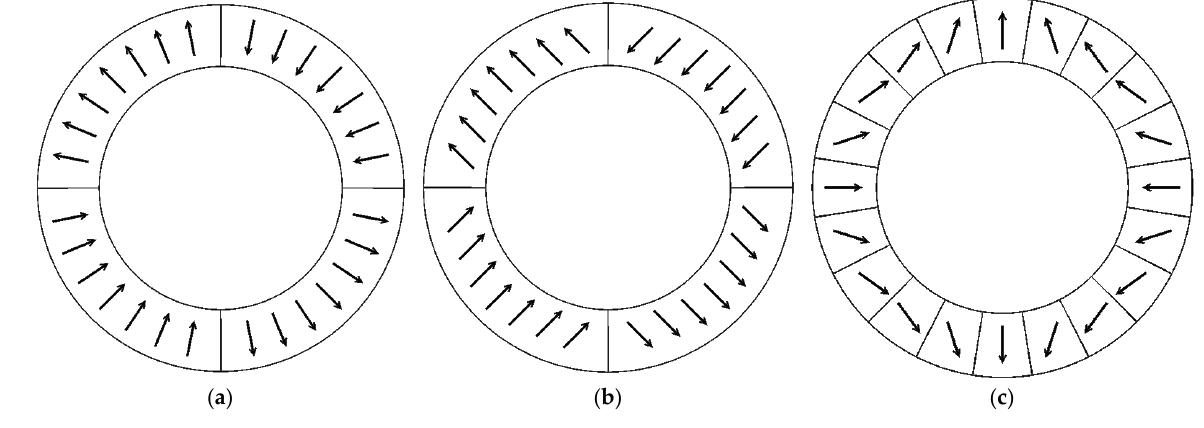
Figure 7. PM magnetization methods. ( a ) Radial magnetization; ( b ) parallel magnetization; ( c ) Hal- bach magnetization.